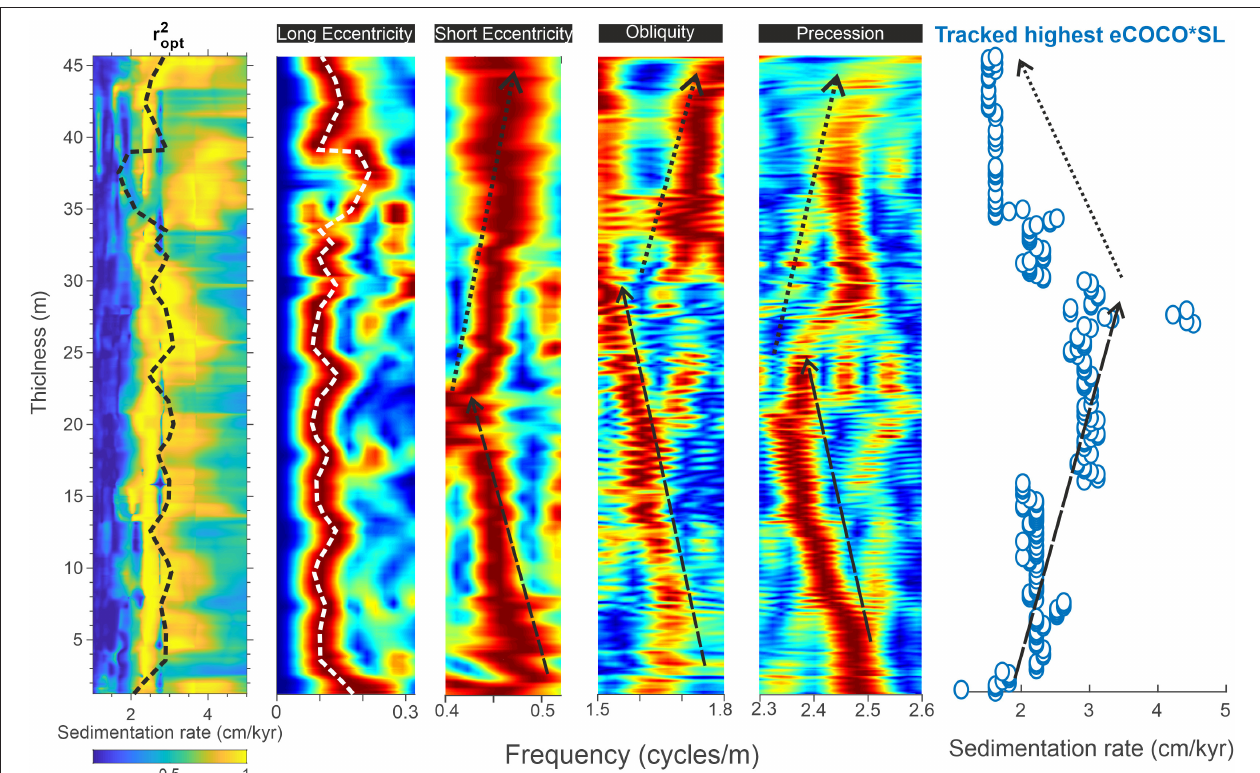
FIGURE 9 | Comparison of the EHA with results from eTimeOpt (extreme left) and eCOCO (extreme right). EHA was applied independently for each orbital parameter apart to allow a better expression of each corresponding amplitude. Dashed arrows indicate increasing SARs while the dotted ones indicate decreasing